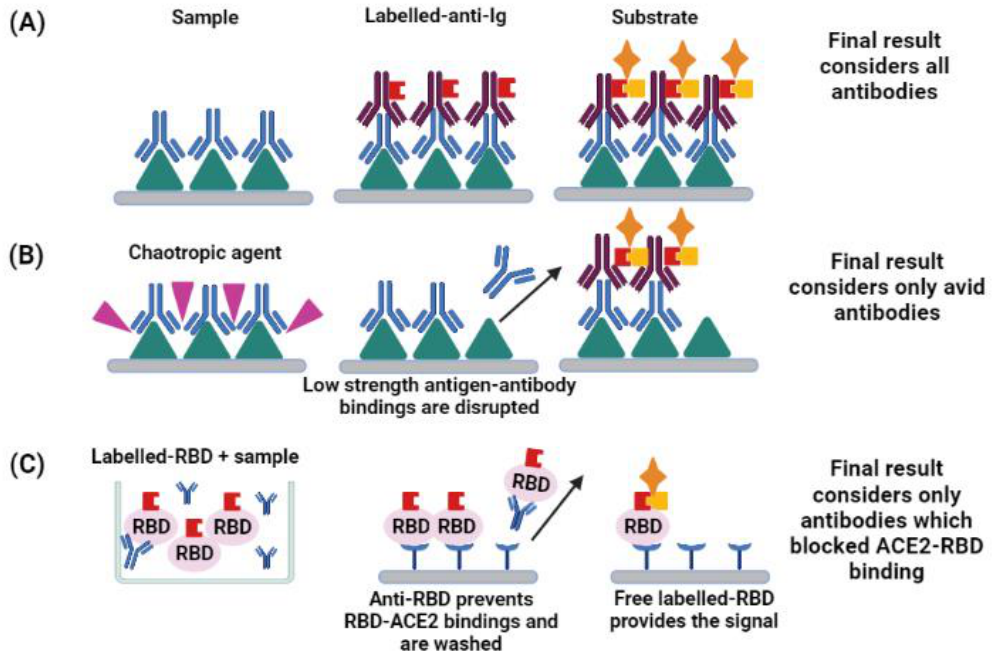
Figure 2. Differences in non-functional and functional enzyme-linked assays. While non-functional assays ( A ), like regular ELISA, detect antibodies that are bound with the antigen, functional assays detect antibodies regarding specific characteristics. ( B ) Avidity assays consist in adding a chaotropic agent that will disturb the epitope-paratope interaction, disrupting weak bindings. Only avid antibodies keep attached and are revealed in the final result. Both A and B assays should consider which antigen of SARS-CoV-2 was used to coat the plate (e.g., RBD, Spike protein, Nucleocapsid protein) and the specificity of the anti-Ig used for detection (e.g., anti-IgA, anti-IgM, anti-IgG). For quantitative results, the higher the signal, the higher the antibody quantity. ( C ) Surrogate-virus neutralization assays, based on a competitive ELISA, allow the interaction between labelled-RBD and the sample, after that, the mix is incubated in ACE-2 coated plates. Therefore, free-RBD binds to the plate and complexes antibody-labelled-RBD, which cannot bind with it, are washed. It should be noted that the assay considers all anti-RBD antibodies, despite its Ig class. For quantitative results, the lower the signal, the higher is the antibody quantity. (figure created with BioRender). The affinity maturation is a well-known feature of the immune response. Once the antigen is presented to B lymphocytes, Immunoglobulin (Ig) gene segments